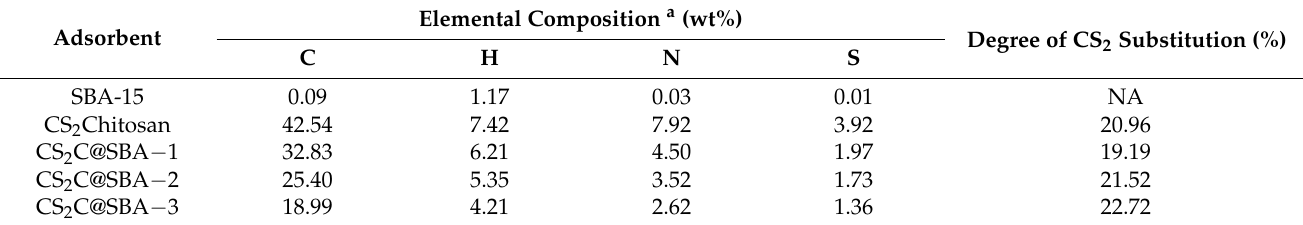
Table 1. Elemental composition of synthesized